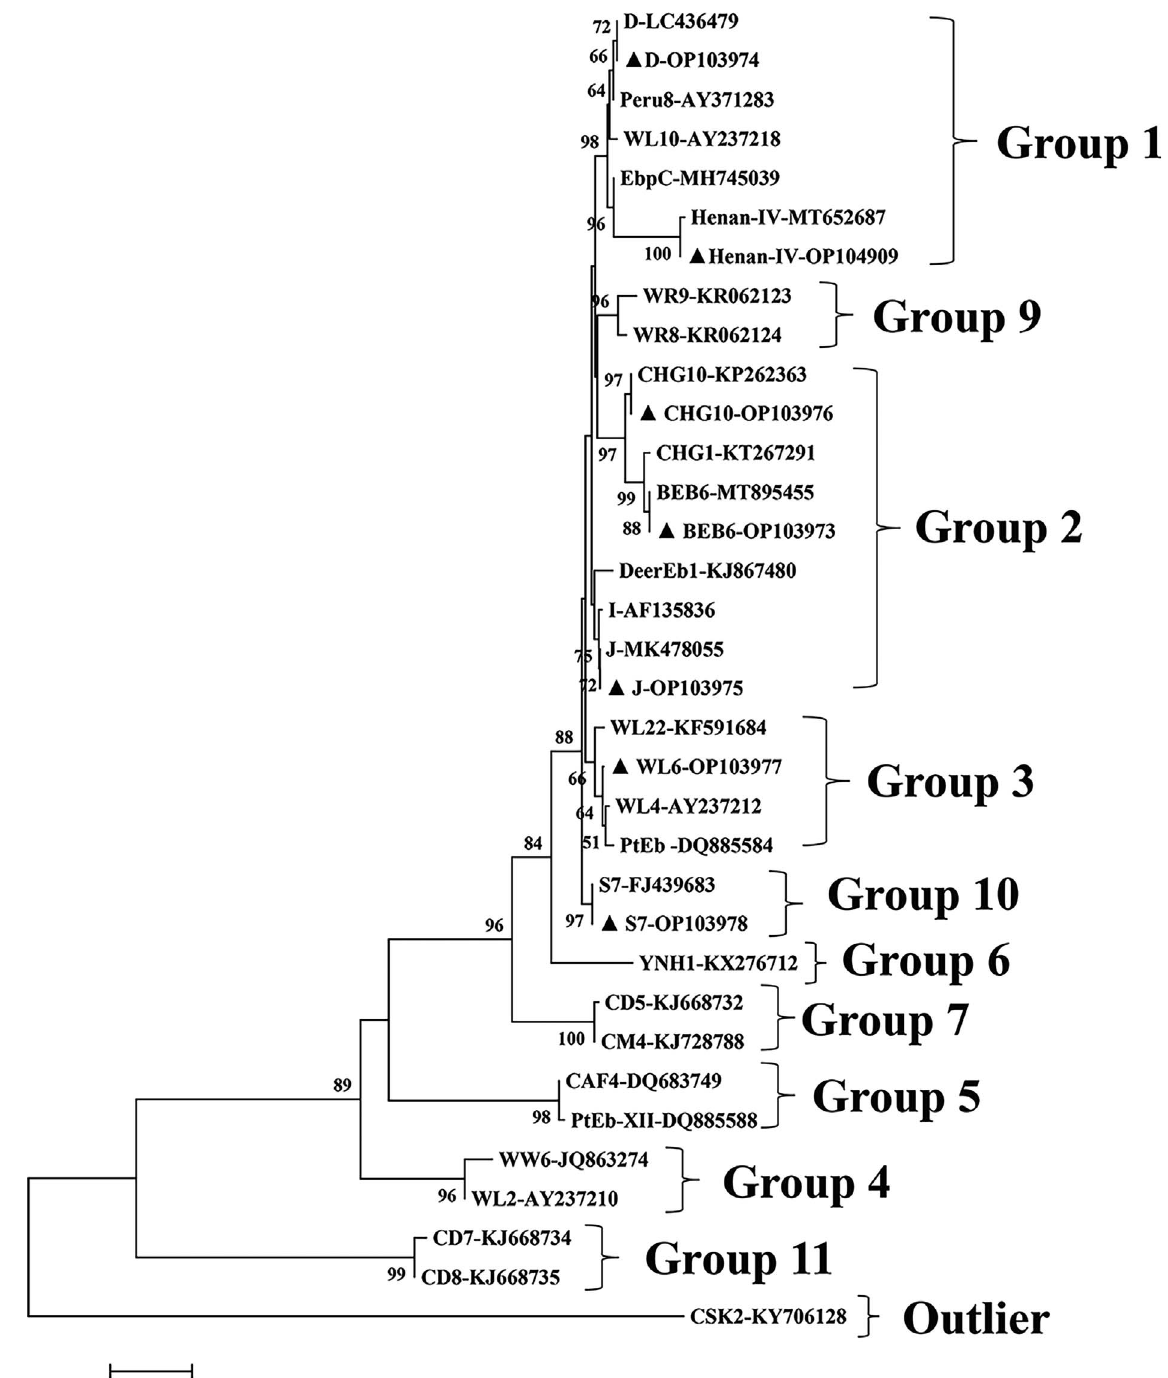
Figure 3. Neighbor-joining tree based on E. bieneusi ITS sequences. N : Genotypes from this